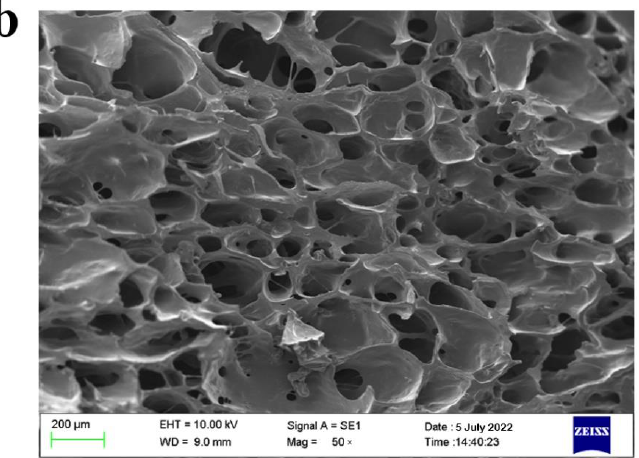
Figure 5. Scanning electron microscopy analysis of the freeze-dried restructured strawberry blocks (magnification 50 × ): ( a ): untreated samples, ( b ) samples with the optimal combination of edible gum additions.